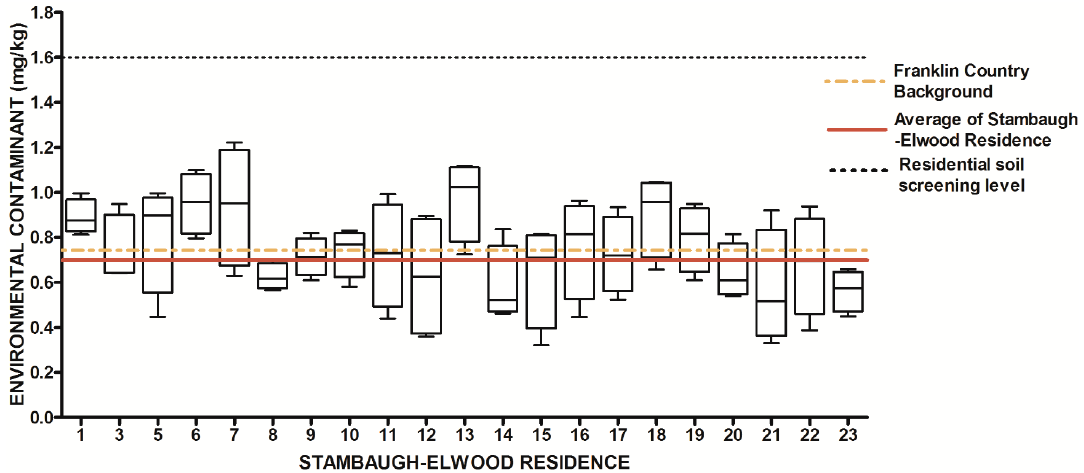
Figure 13. Residential urban soil level of Ti in the Stambaugh-Elwood community versus Franklin County (background), common averages and residential screening levels (RSLs) (mg/kg soil). Soil samples were taken from 21 of 46 residences that consented for the study in compliance with